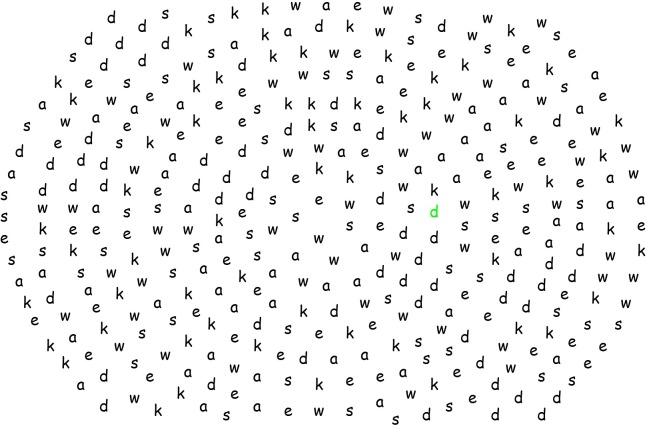
The Ellipses Test (Roczniewska et al., 2011). In this example, one letter has been selected – the d marked in green font.